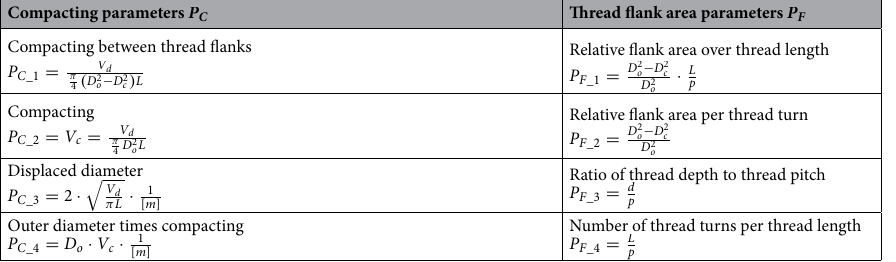
Table 1. Parameters considered for compacting P C and thread flank area P F , with V d —displaced